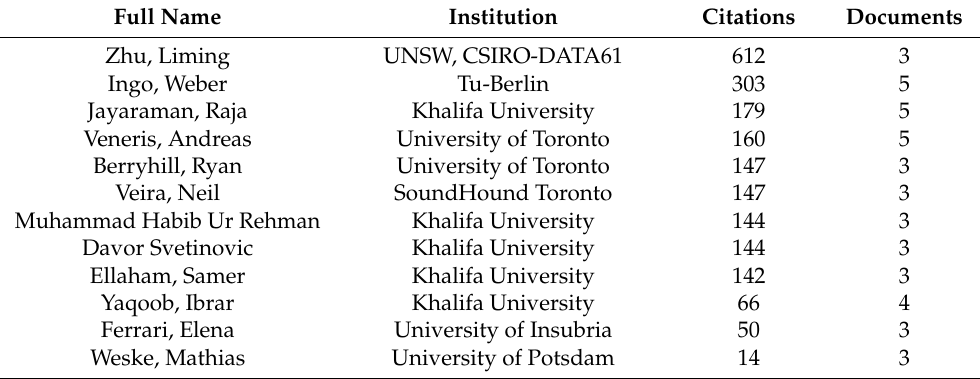
Table A2. Notable coauthors.